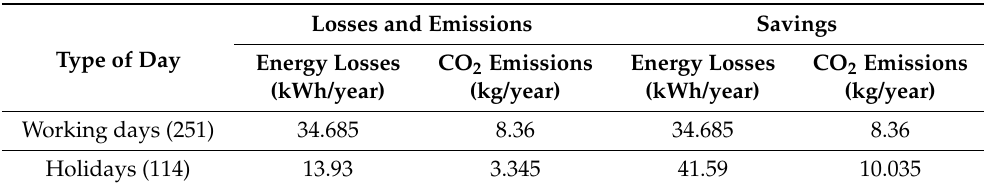
Table 10. Annual energy losses ( W (cid:48) ) and CO 2 emissions caused by distorted currents and savings ch after the optimization in the operation of the capacitor bank Q c 2 .